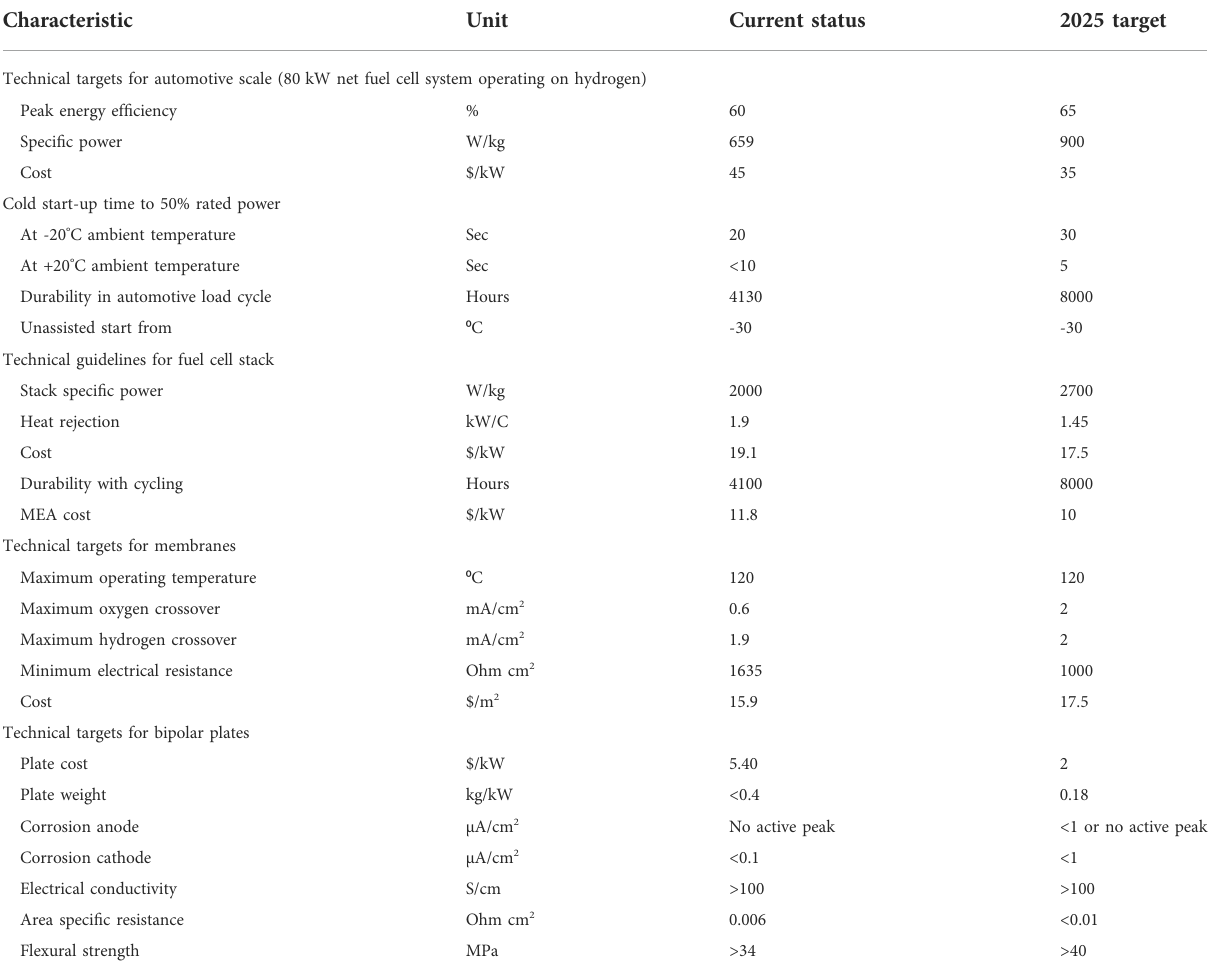
TABLE 1 Targets and current status of fuel cell characteristics as per DOE, United States (Drive U, 2013).